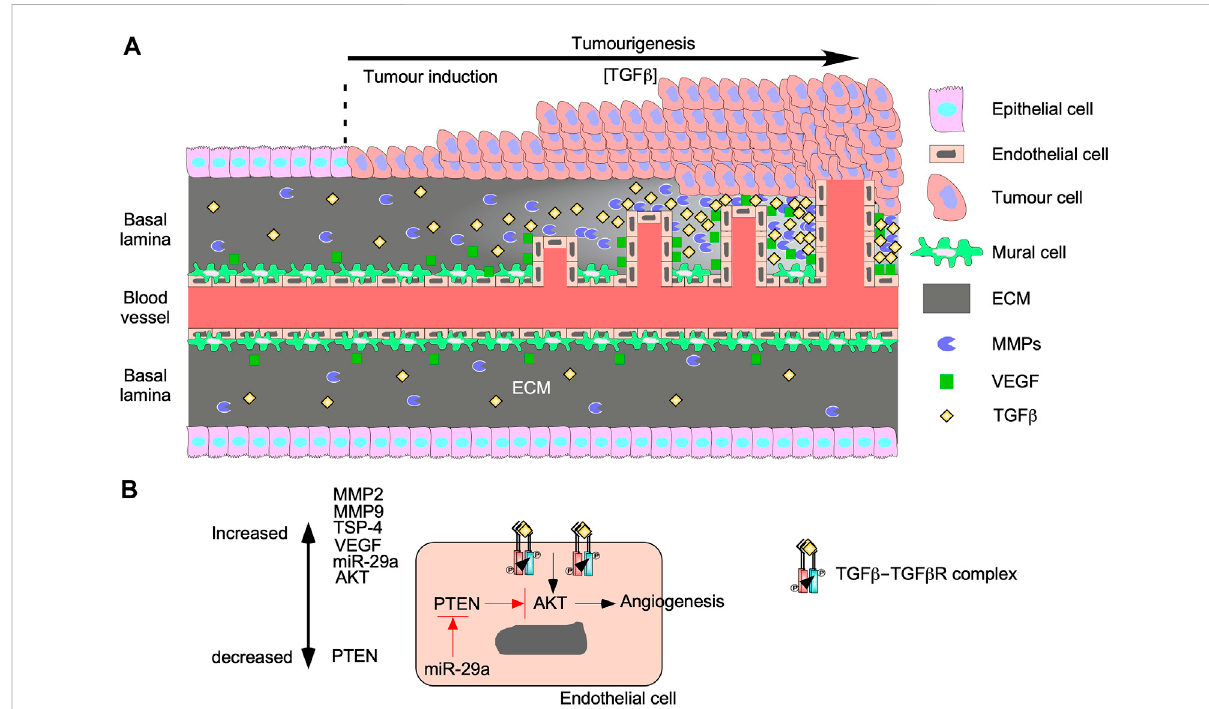
FIGURE 7 TGF β augments tumourigenesis by inducing angiogenesis. (A) As tumours grow, the concentration of transforming growth factor- β (TGF β ) in the tumour microenvironment increases. TGF β upregulates genes involved with proliferation and migration in mural cells, which results in endothelial cell migration and leaky vessels. TGF β binds to TGF β receptors on endothelial cells to upregulate vascular endothelial growth factor (VEGF)andmatrixmetalloproteinases(MMPs).BothproteinsaresecretedintothebasallaminaandincreaseproportionallytoTGF β .VEGFbinds to endothelial cells and stimulates proliferation and migration. MMPs breakdown proteins in the basal lamina to remodel the extracellular matrix (ECM) to carve out space for vessel formation. The new vessels grow and become more organized as time passes. (B) TGF β binds to TGF β